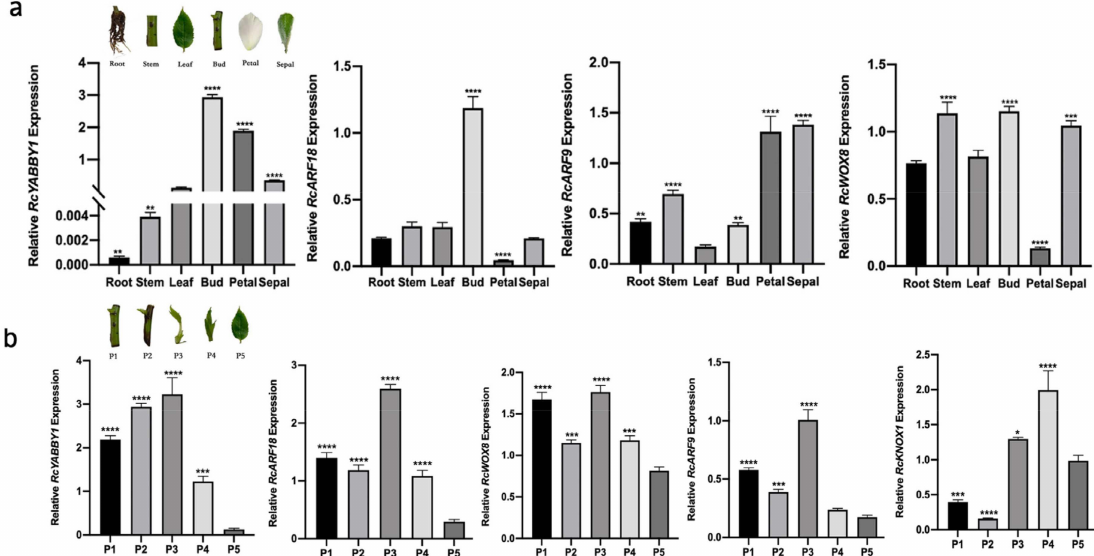
Figure 6. Expression patterns of candidate genes RcYABBY1, RcARF18, RcARF9, and RcWOX8 in Rosa multiflora ‘Libellula’: ( a ) expression patterns in different organs of R. multiflora ‘Libellula’; ( b ) expression patterns in R. multiflora ‘Libellula’ leave at different developmental stages. Asterisks indicate significant differences among treatments (* p < 0.05; ** p < 0.01; *** p < 0.001; **** p < 0.0001). The vertical bars indicate the standard deviations of the means of three